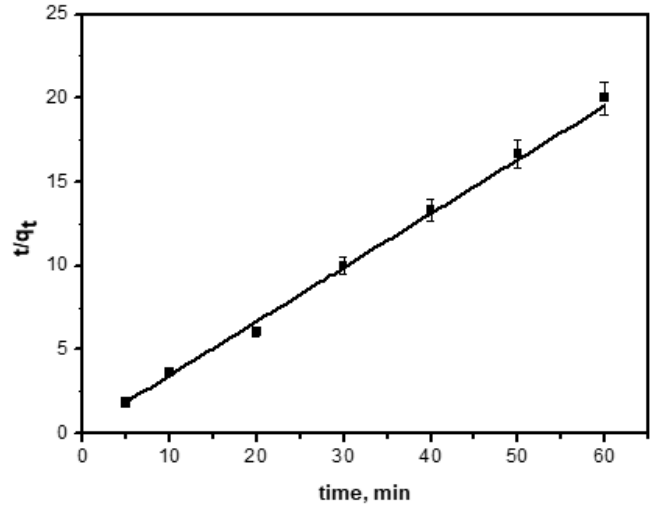
Figure 7. Pseudo-second-order kinetics.